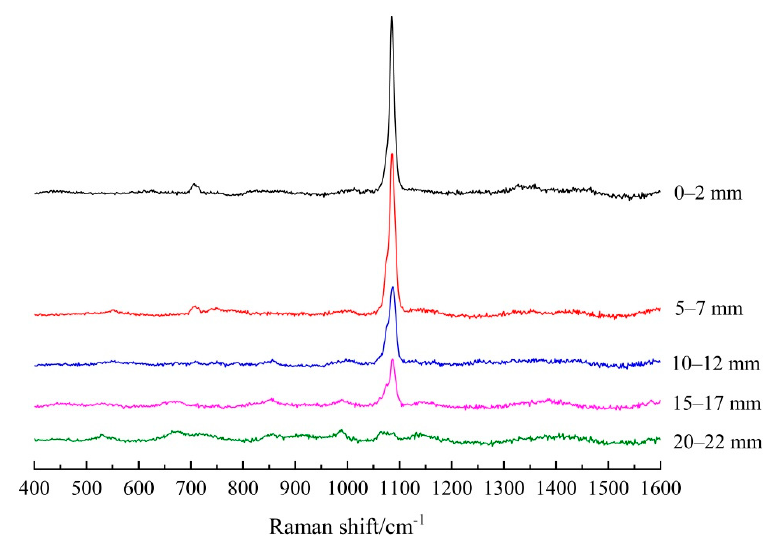
Figure 5. Raman spectra (after the subtracting background) of the powders collected at five depths of carbonated GGBS/PC paste samples.